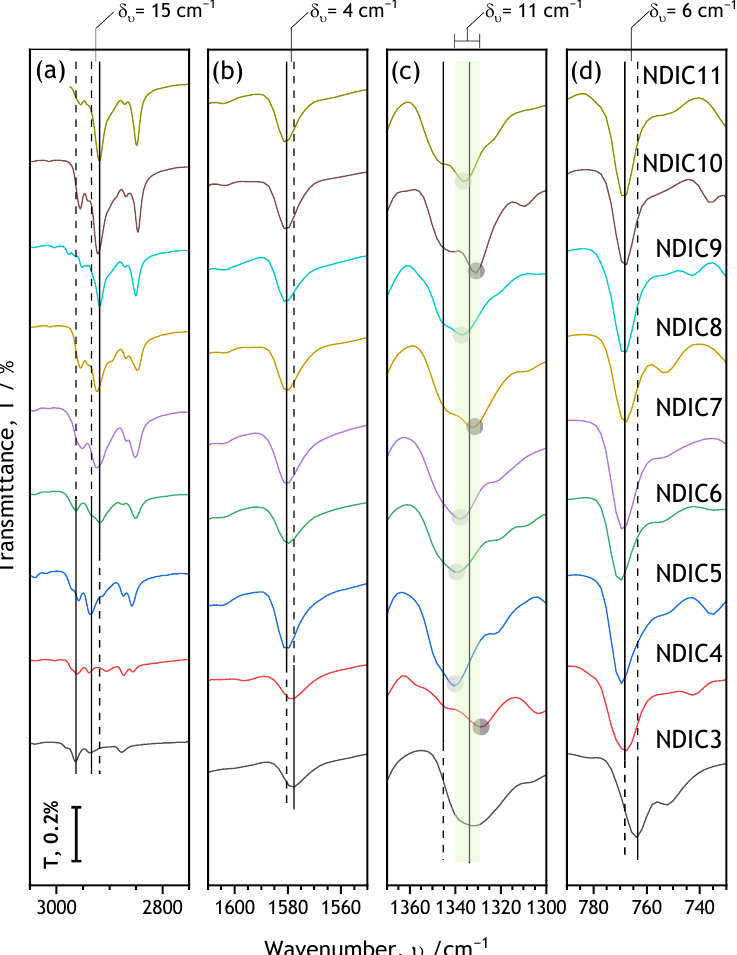
Figure 5. Characteristic regions of FTIR spectra (Full spectra are shown in Figure S2 in the Supple- mentary Materials; see also Table S7 in the Supplementary Materials). For clarity, the spectra are shifted along the transmittance scale. The common transmittance scale bar is in the lower left corner. For the range of NDIs where the absorption peaks are observed at certain constant wavenumber (υ) the peak positions are marked with vertical solid lines. Dashed lines serve as guides to the eye. See the text for assignments of peaks to vibrations.